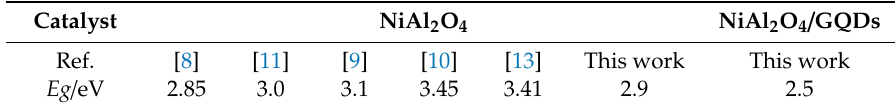
Figure 7. UV–Vis diffuse reflectance profile of the ( a ) NiAl 2 O 4 and the ( b ) NiAl 2 O 4 /GQDs composite Figure 7. UV–Vis di ff use reflectance profile of the ( a ) NiAl 2 O 4 and the ( b ) NiAl 2 O 4 / GQDs composite annealed at 800 °C. annealed at 800 ◦ C. Table 1. Energy band gap ( Eg ) of the NiAl 2 O 4 / GQDs composite and NiAl 2 O 4 reported in this work Table 1. Energy band gap ( Eg ) of the NiAl 2 O 4 /GQDs composite and NiAl 2 O 4 reported in this work and and elsewhere.